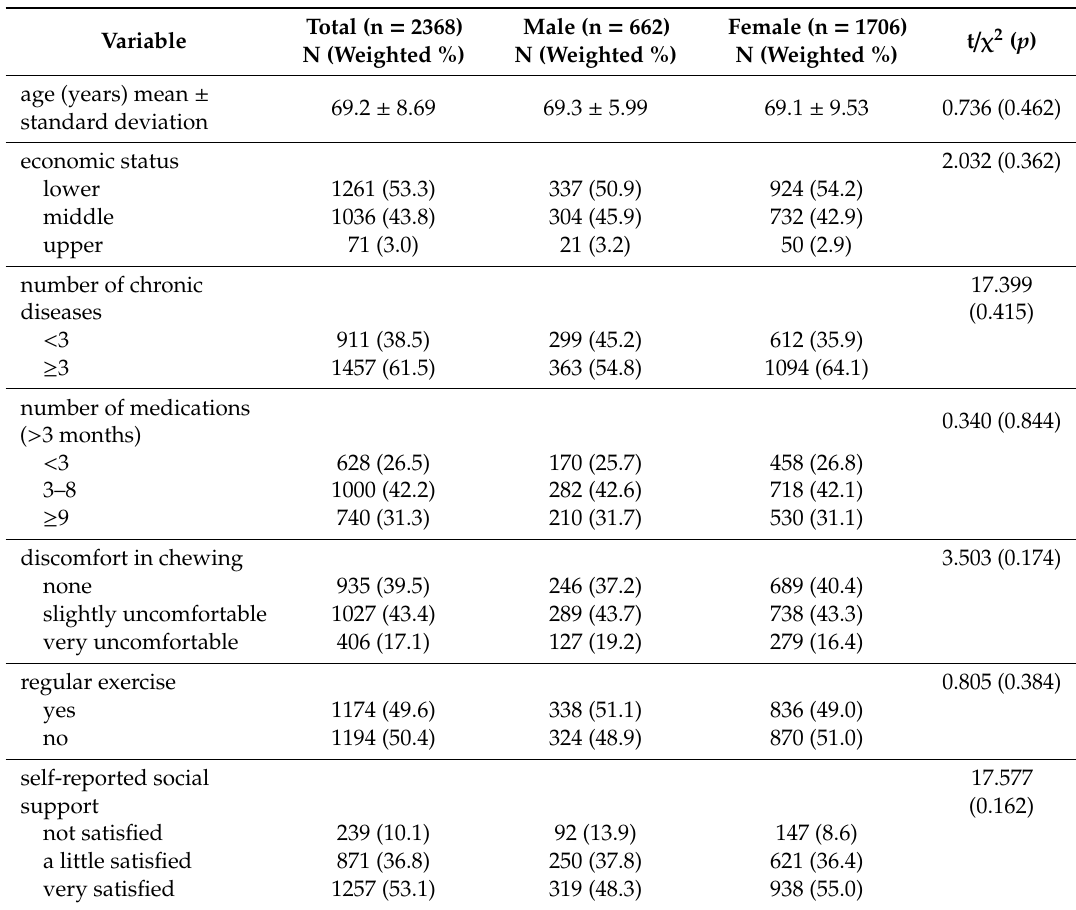
Table 1. Sociodemographic characteristics (n = 2368).